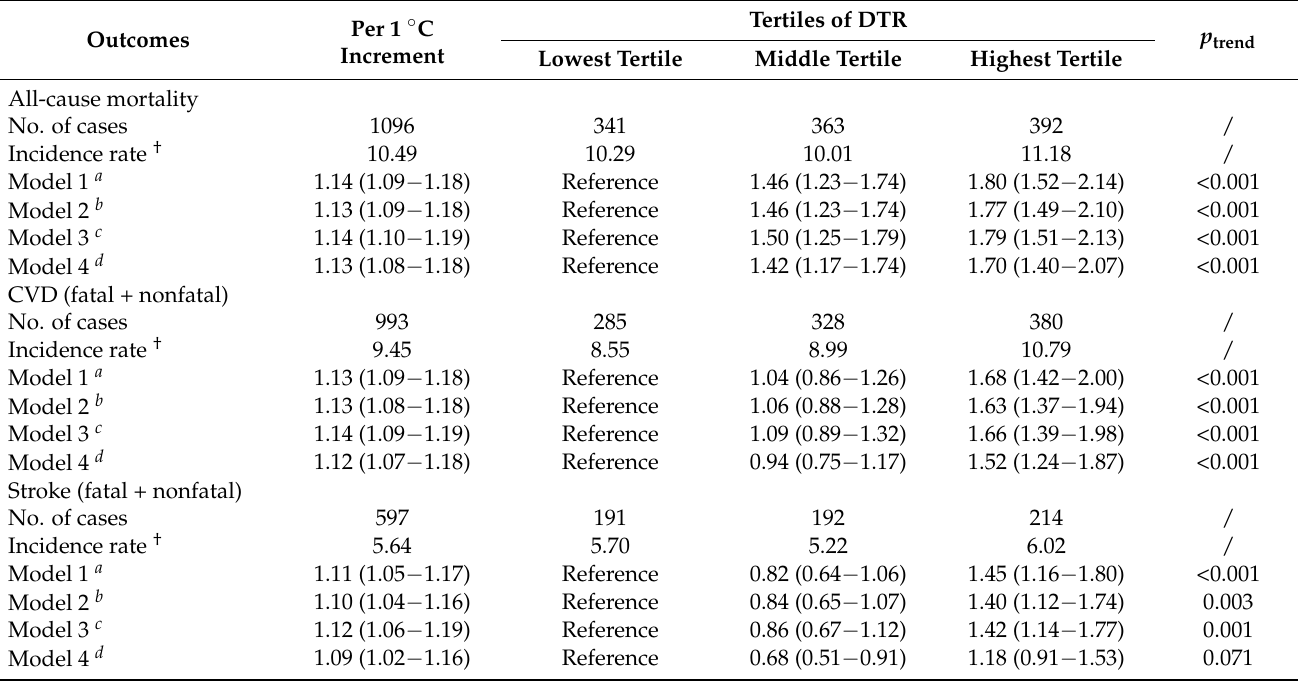
Table 2. Hazard ratios and 95% CI for long-term diurnal temperature range with all-cause mortality, CVD, and stroke.